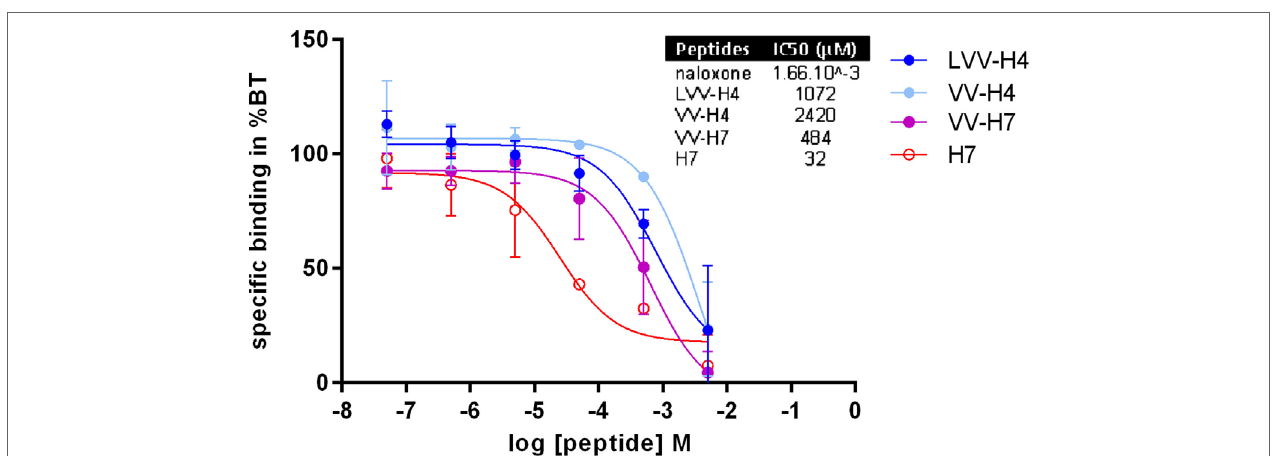
FigUre 6 | Determination of hemorphins binding to rat brain membranes opioid receptors (OPs). The ability of the hemorphins/opioid peptides to bind to OPs was assessed in a radiobinding assay in vitro by competition with H3-naloxone (non-selective OP antagonist) on rat brain membrane preparation. Six concentrations ranging from 5 × 10 − 8 to 5 × 10 − 3 M were tested in duplicates and the results were expressed as a percentage of total binding without opioid peptides. Inset: dose–response curves were analyzed in GraphPad Prism 6 by non-linear regression from which IC 50 were interpolated. Data presented are mean (average of two separate assays) ± SD.